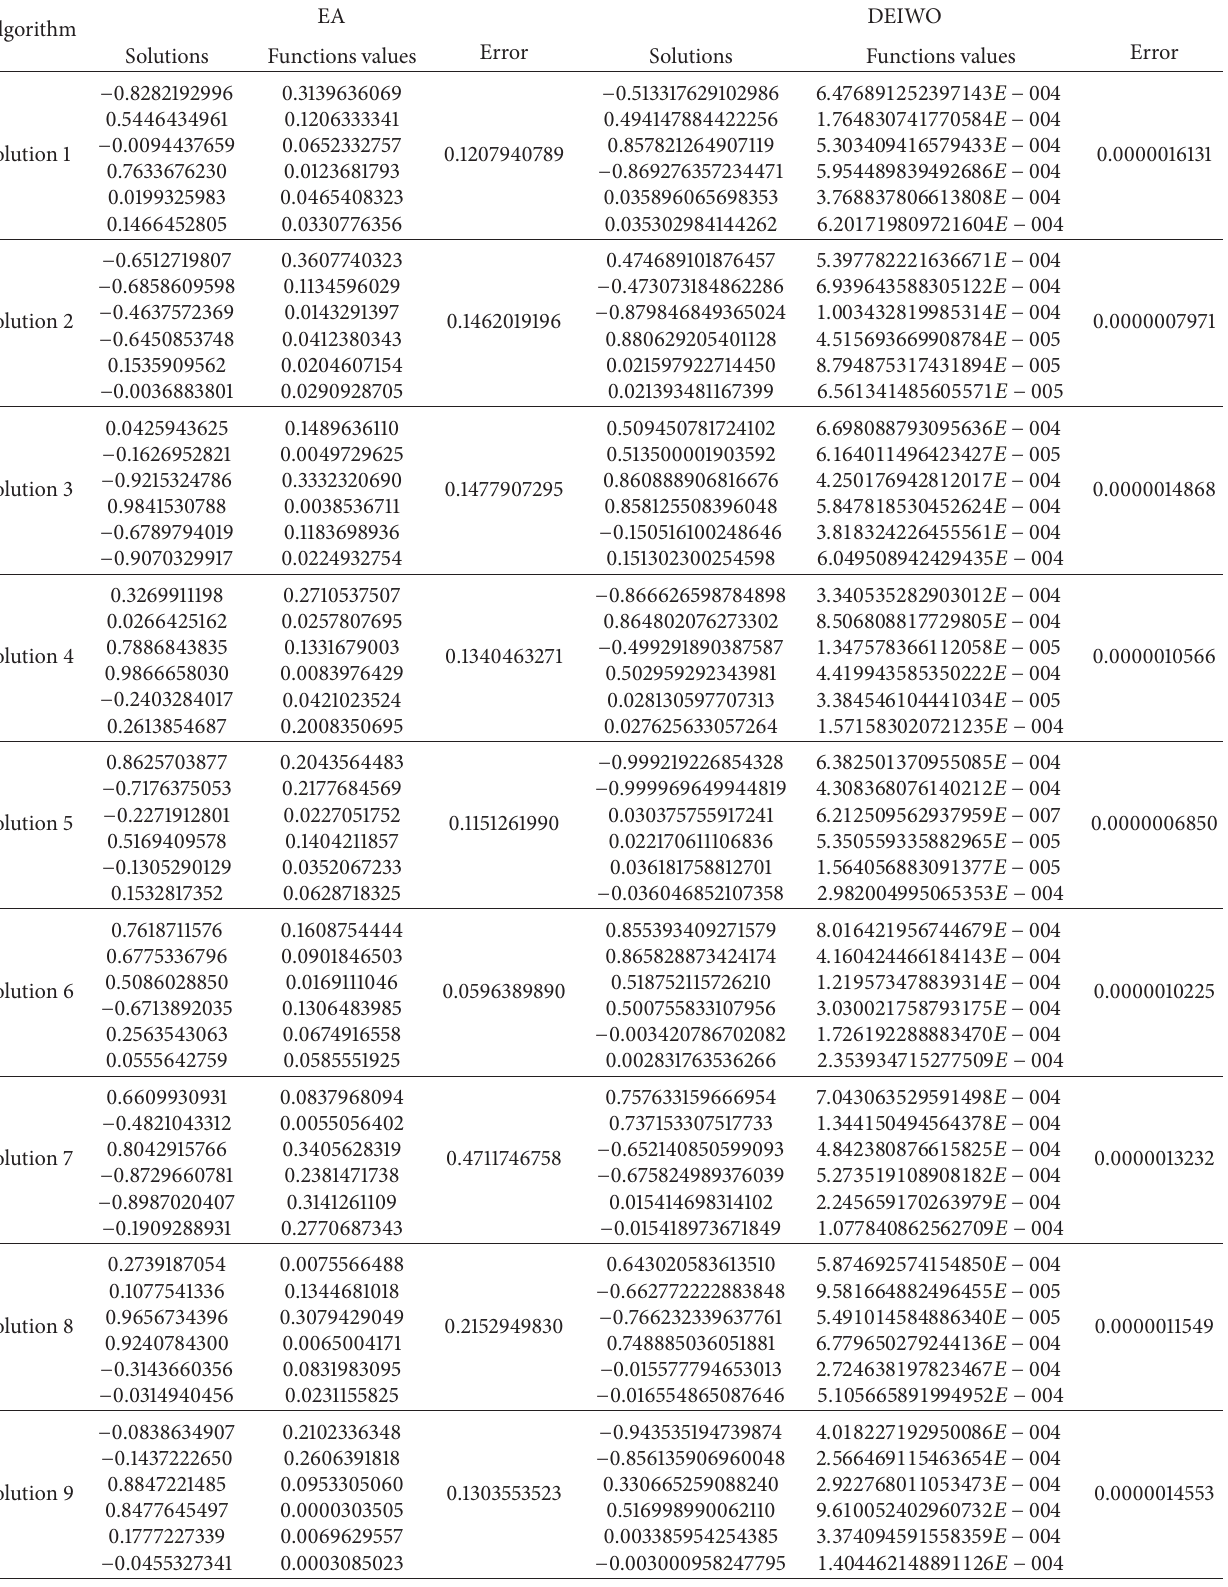
Table 7: Comparison of results for neurophysiology application